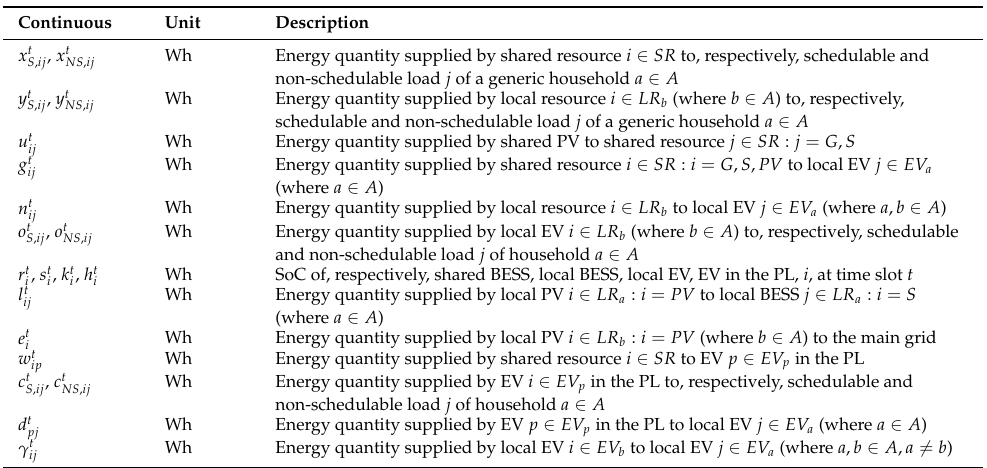
Table 4. Decision